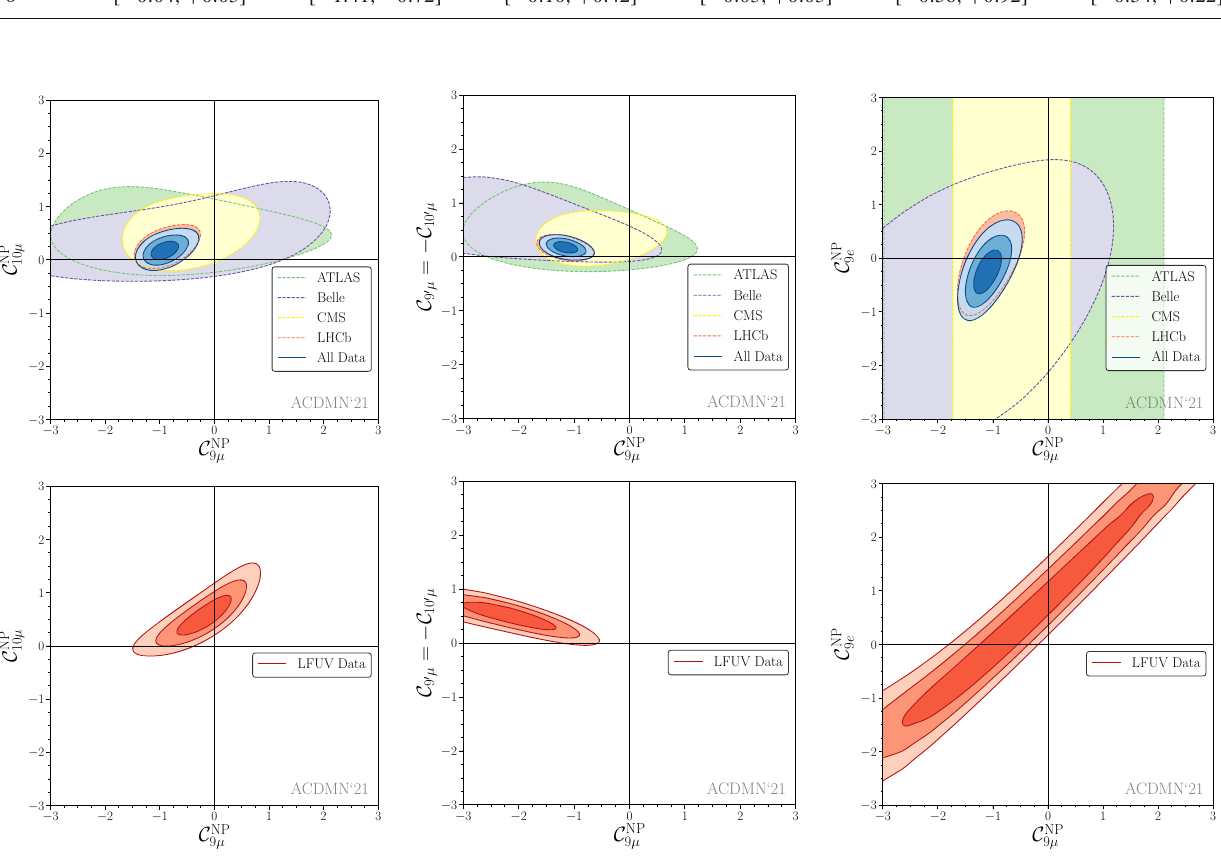
, C NP ) , ( C NP , C = − C ) and ( C NP , C NP ) planes for the corresponding 2D hypotheses, 9 (cid:4) μ 10 (cid:4) μ 9 μ 10 μ 9 μ 9 μ 9 e